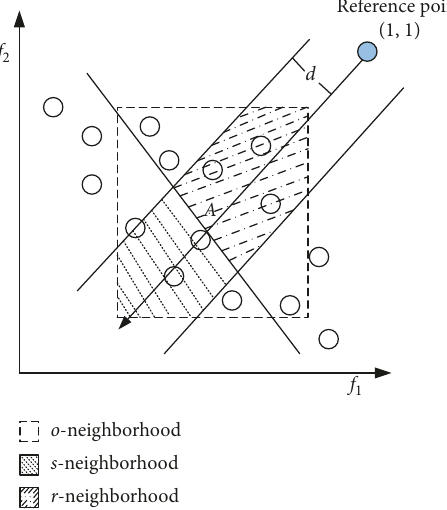
Figure 4: Illustration of the proposed DDN